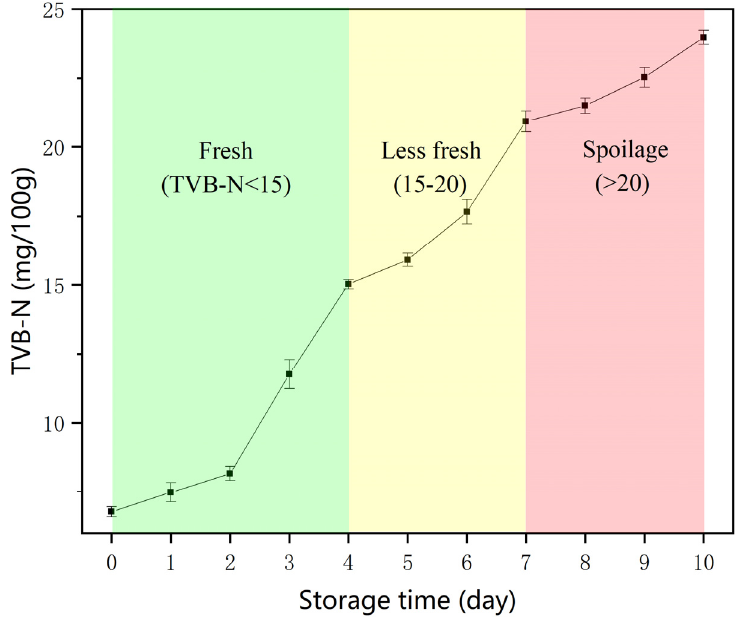
Figure 6. Changes in TVB-N for packaged chilled broiler meat stored at 4 °C.